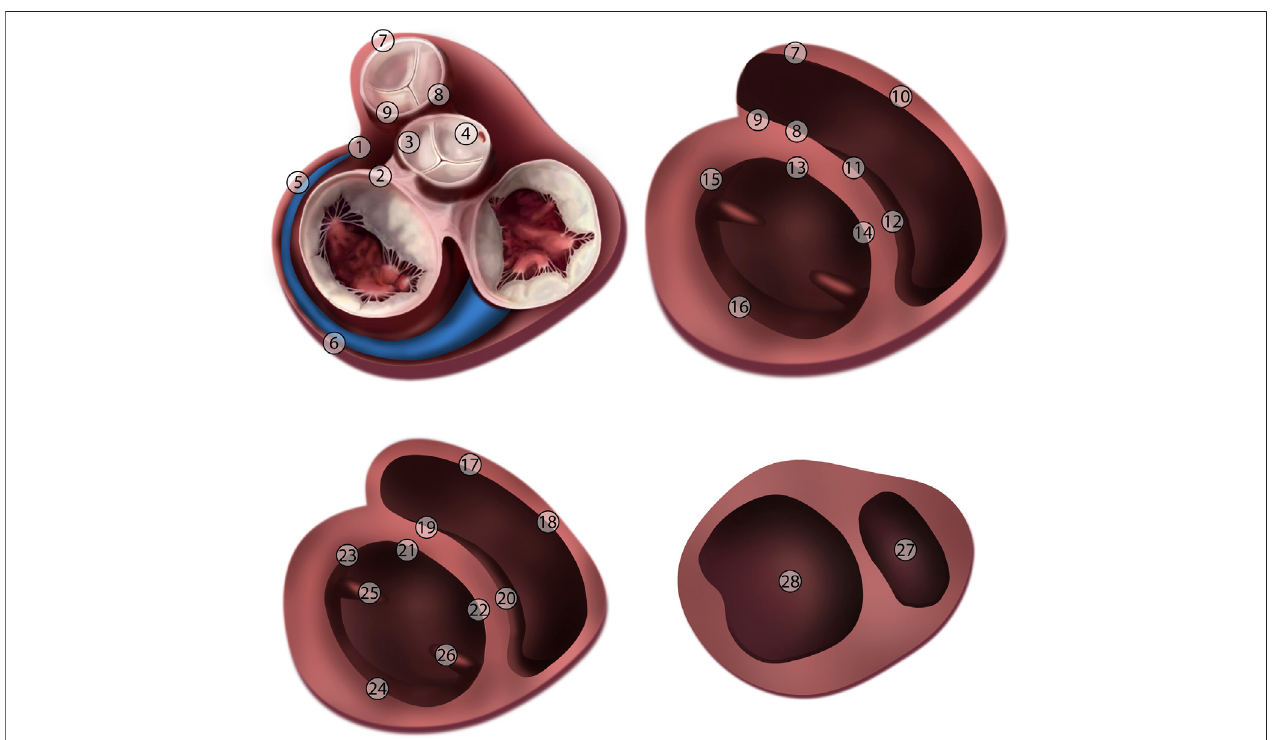
FIGURE2| Ventricularheartmodelwith28segmentswithepicardial,basal,midand apicalview.1)Leftventriclesummit; 2)Aortomitral continuity; 3)Leftcoronary cups;4)Rightcoronarycusp;5)Leftventricleanterolateralwall;6)Leftventricleposterolateralwall;7)Rightventricleout fl owtractfreewall;8)Rightventricleout fl owtract posteroseptal wall; 9) Right ventricle anteroseptal wall; 10) Right ventricle free wall; 11) Right ventricle anteroseptal wall; 12) Right ventricle posteroseptal wall; 13) Left ventricle anteroseptal wall; 14) Left ventricle posteroseptal wall; 15) Left ventricle anterolateral wall; 16) Left ventricle posterolateral wall; 17) Right ventricle anterolateralfreewall;18)Rightventricleposterolateralfreewall;19)Rightventricleanteroseptalwall;20)Rightventricleposteroseptalwall;21)Leftventricleanteroseptal wall; 22) Left ventricle posteroseptal wall; 23) Left ventricle anterolateral wall; 24) Left ventricle posterolateral wall; 25) Anterolateral papillary muscle; 26) Posteromedial papillary muscle; 27) Right ventricle apex; 28) Left ventricle